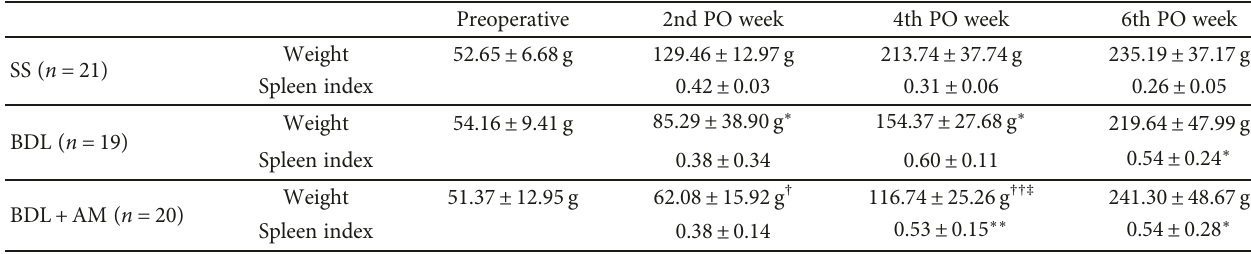
Figure 2: In comparison with the control group, in both the BDL groups, cholestasis was clinically evident, characterized by icteric coloration of face, legs, and tail (arrows). Additionally, yellowish pigmentation was observed in the gravel of boxes (choluria), and stools were clearly pale (acholia) (arrowheads). Table 2: Preoperative and postoperative weight and spleen